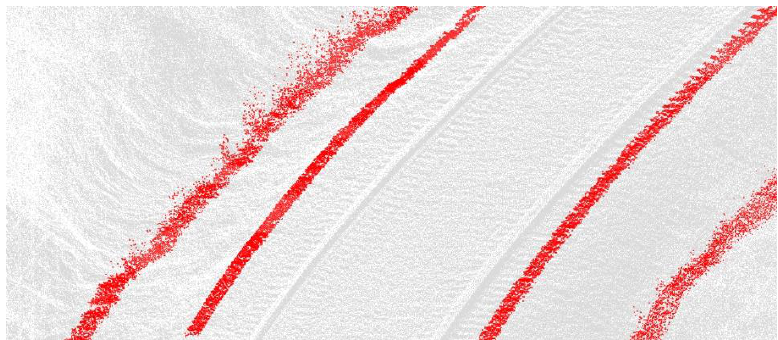
Figure 11. Scan angle top and bottom ballast points classification ( red ).